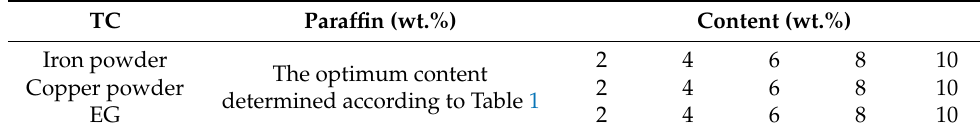
Table 2. TC contents in the TC/PA/gypsum